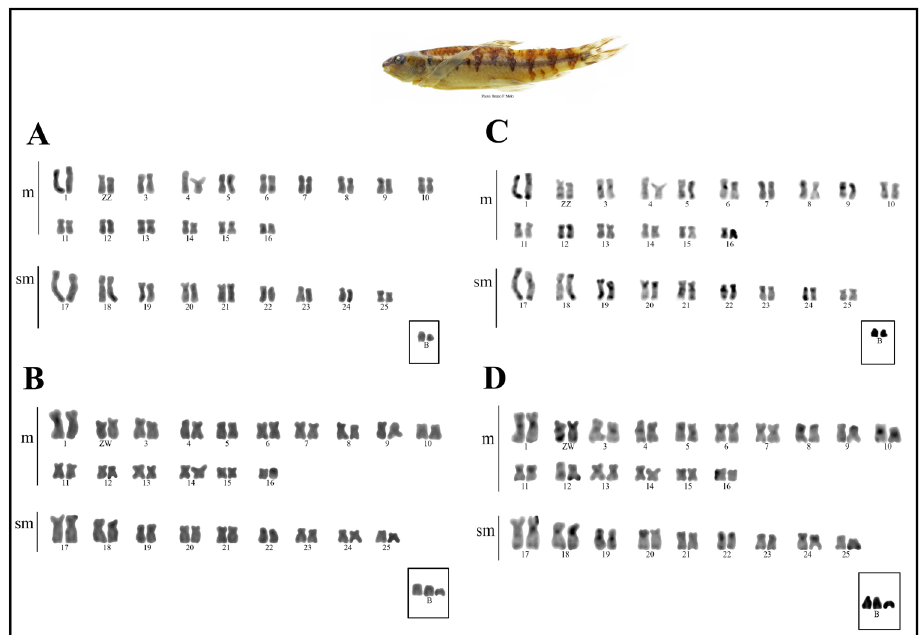
FIGURE 1 | Characidium sp. aff. C . vidali karyotypes arranged from mitotic metaphases after to conventional Giemsa staining and C-banding. A. and C. male karyotypes. B. and D. female karyotypes. B chromosomes are in the boxes. In evidence a preserved specimen under study. Photo of Characidium sp. aff. C . vidali by Bruno F. Melo.